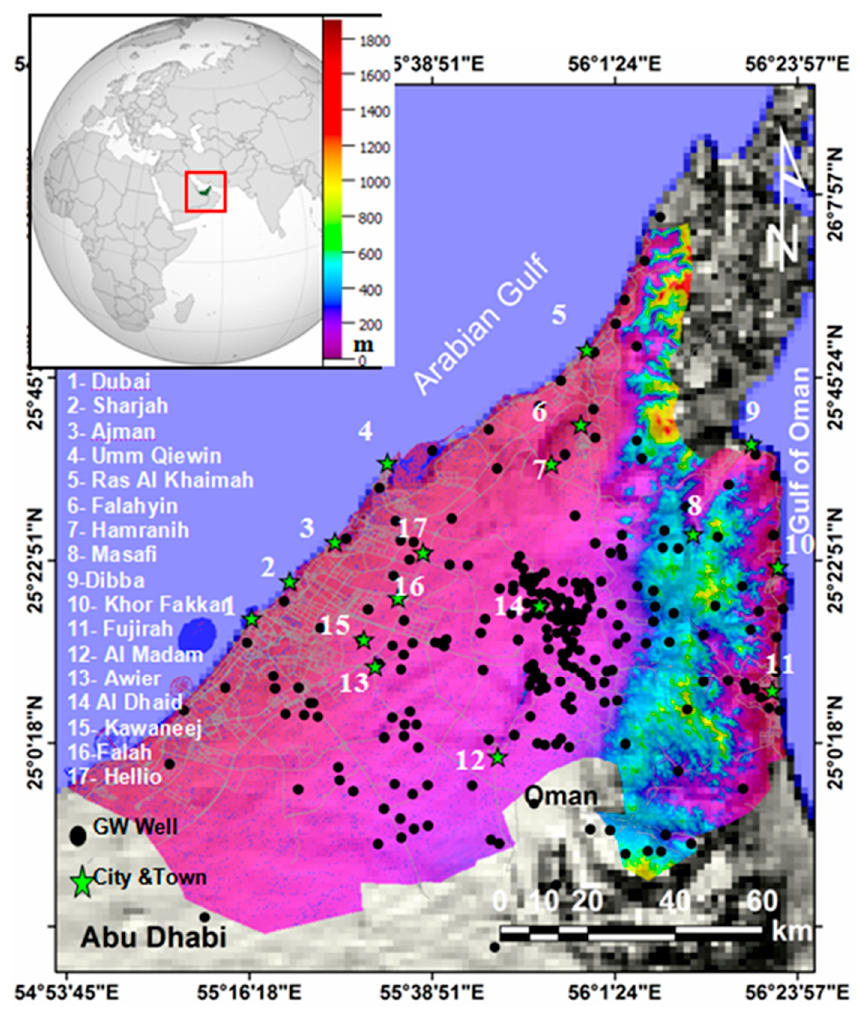
Figure 1. Elevation map generated from a DEM showing the location of the study area and main cities and.